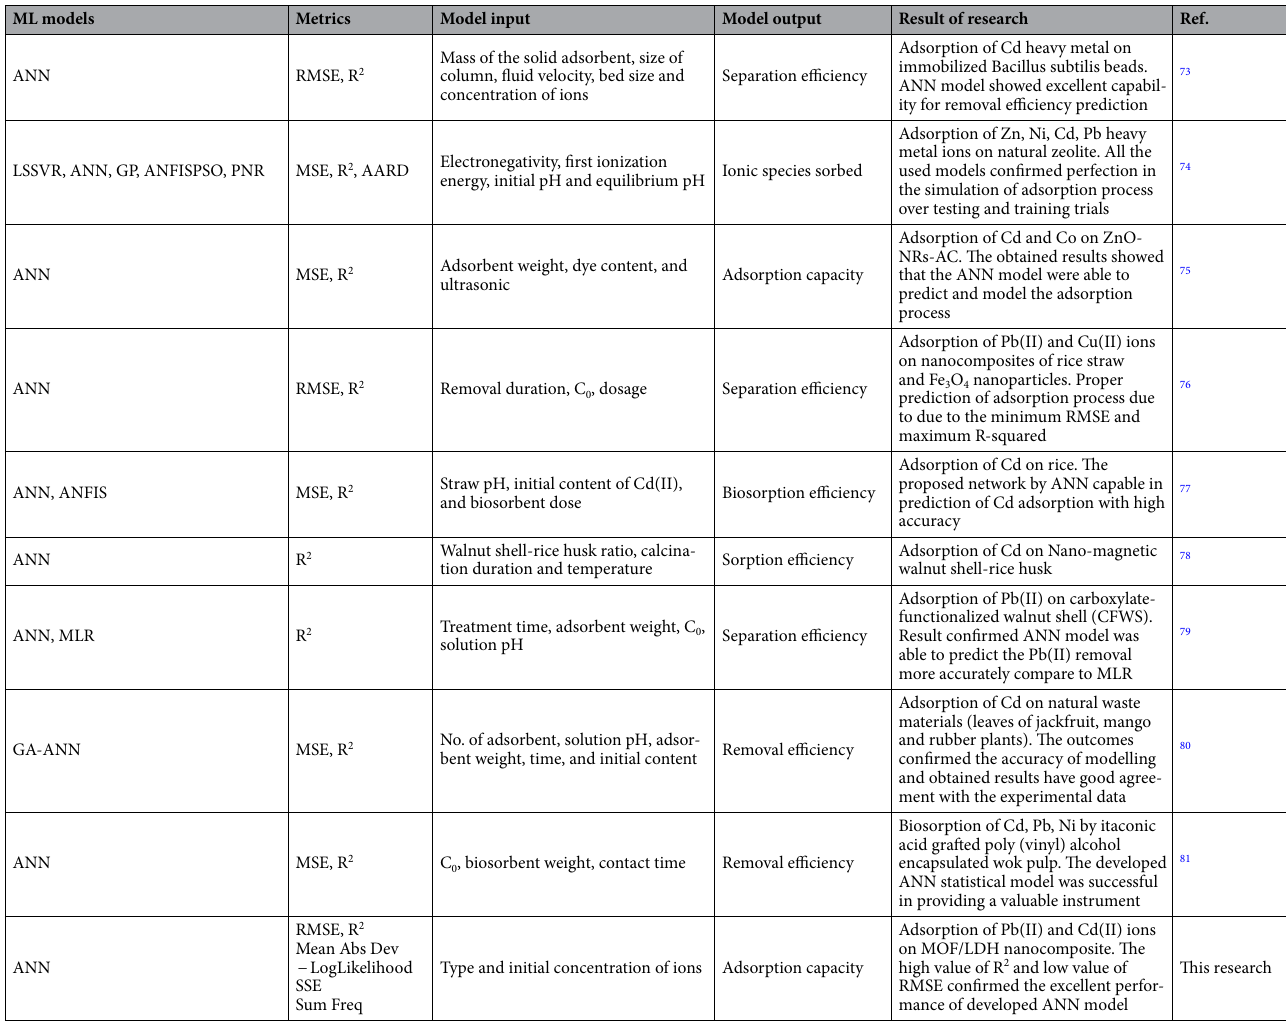
Table 2. Comparison of different reports on ML modeling methods, especially ANN method, for Cd and Pb heavy metal ions removal 72